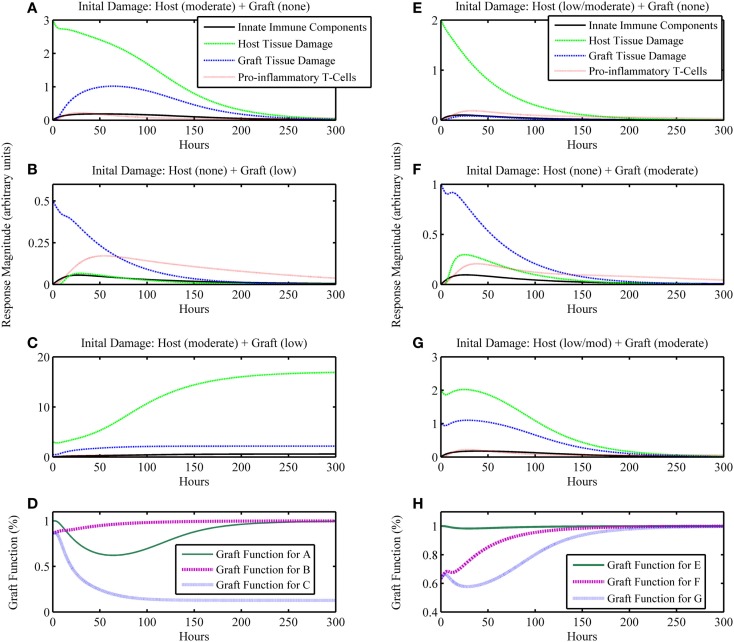
Simulation results of the inflammatory cascade following transplant surgery and non-allo-Ag graft placement (i.e., α = 0). Combined initial host and graft IRI can synergize to incite an inflammatory response that (A–D) cannot resolve, causing graft failure or (E–H) transiently decrease graft function significantly. (A–C) present a series of simulations in which (A) a moderate level of initial surgical IRI in the host is considered with no corresponding graft IRI associated with the placement, (B) no initial surgical IRI in the host is considered with a low level of initial graft IRI, or (C) the moderate level of initial surgical IRI in the host of simulation (A) is coupled with the low level of initial graft IRI of simulation (B). In (D), the graft functionality curves corresponding to simulations (A–C) are shown. The “Graft function for C” time course in (D) displays the synergy to severely affect graft function such that the graft fails, shown as functionality decreasing to and remaining at 12%. Similarly, panels (E–G) display outcomes for (E) a low/moderate level of initial surgical IRI in the host with no corresponding graft IRI associated with the placement, (F) no initial surgical IRI in the host with a corresponding moderate level of initial graft IRI, or (G) the combination of the low/moderate initial level of surgical IRI in the host from simulation (E) with the moderate level of initial graft IRI from simulation (F). In (H), the graft functionality curves corresponding with (E–G) are shown. The “Graft function for G” time course in (H) displays the synergy to significantly affect graft function, but only transiently after which the graft functionality fully recovers. Initial conditions for (C): (I0, D0, A0, DG0, TP0, TA0) = (0, 3, 0.5, 0.125, 0, 0); initial conditions for (G): (I0, D0, A0, DG0, TP0, TA0) = (0, 2, 1, 0.125, 0, 0).